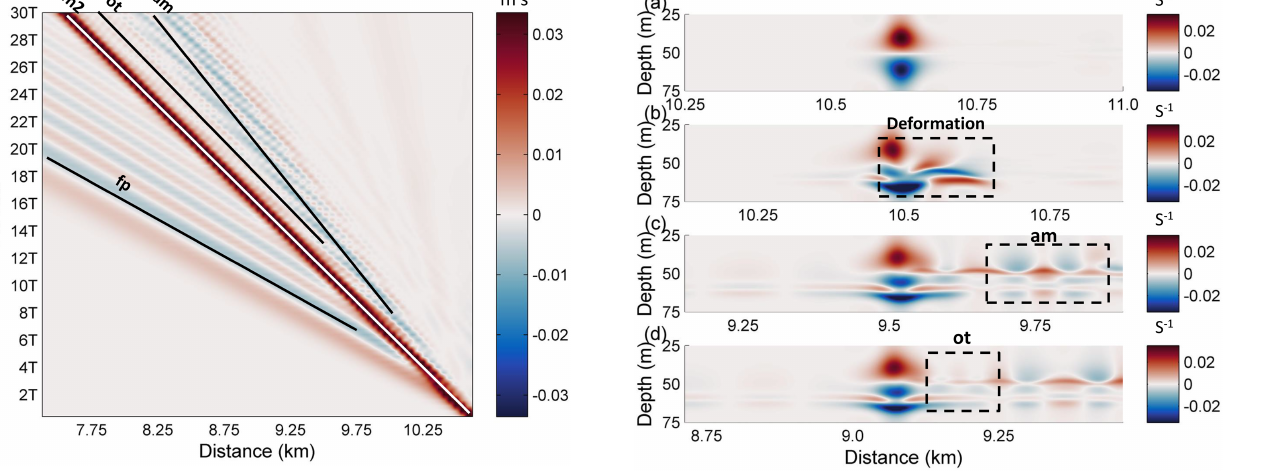
Figure 8. The evolution process of the vorticity field in case O9 ( (cid:49) = 0) for the different times (a) 0 T , (b) 1.2 T , (c) 10 T , and (d) 14 T , where “am” and “ot” denote the amplitude-modulated wave packet and oscillating tail,